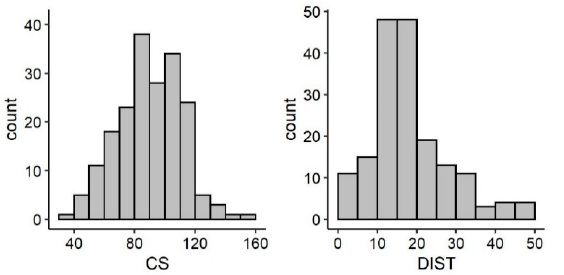
Figure 5. Frequency distribution of CS ( n = 192) and DIST ( n = 176) for all loggerhead turtle nests in Sicily.